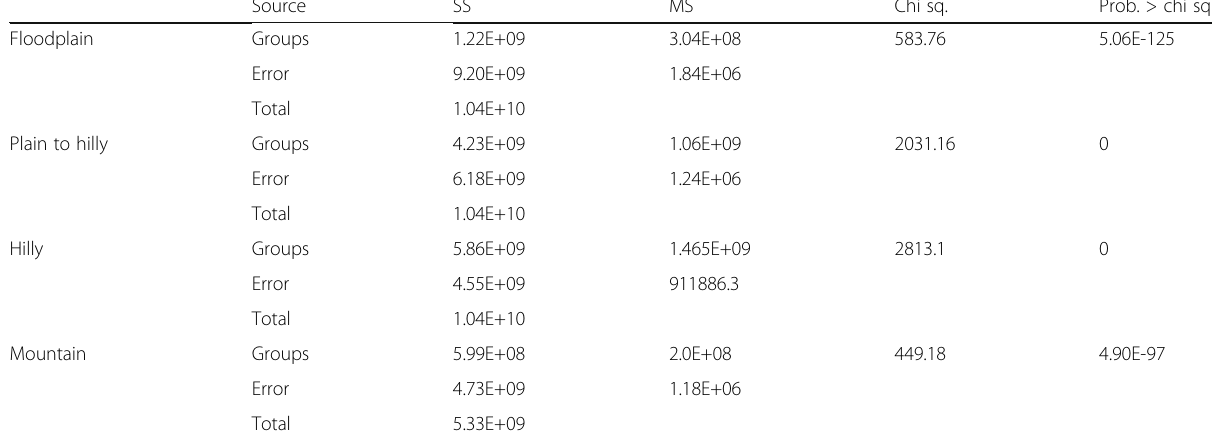
Table 1 Kruskal-Wallis significance tests of difference in slope between different land covers in each study area. Source means the origin of variance, and it includes the variance between groups (different land covers) and error (geomorphometric value in the same land cover); SS means sum of square; MS represent standard deviation, and it could reflect the degree of dispersion of a dataset; chi sq. is the H-statistic of the Kruskal-Wallis test, which is approximately chi-square distributed. The Prob. > chi sq. is the p